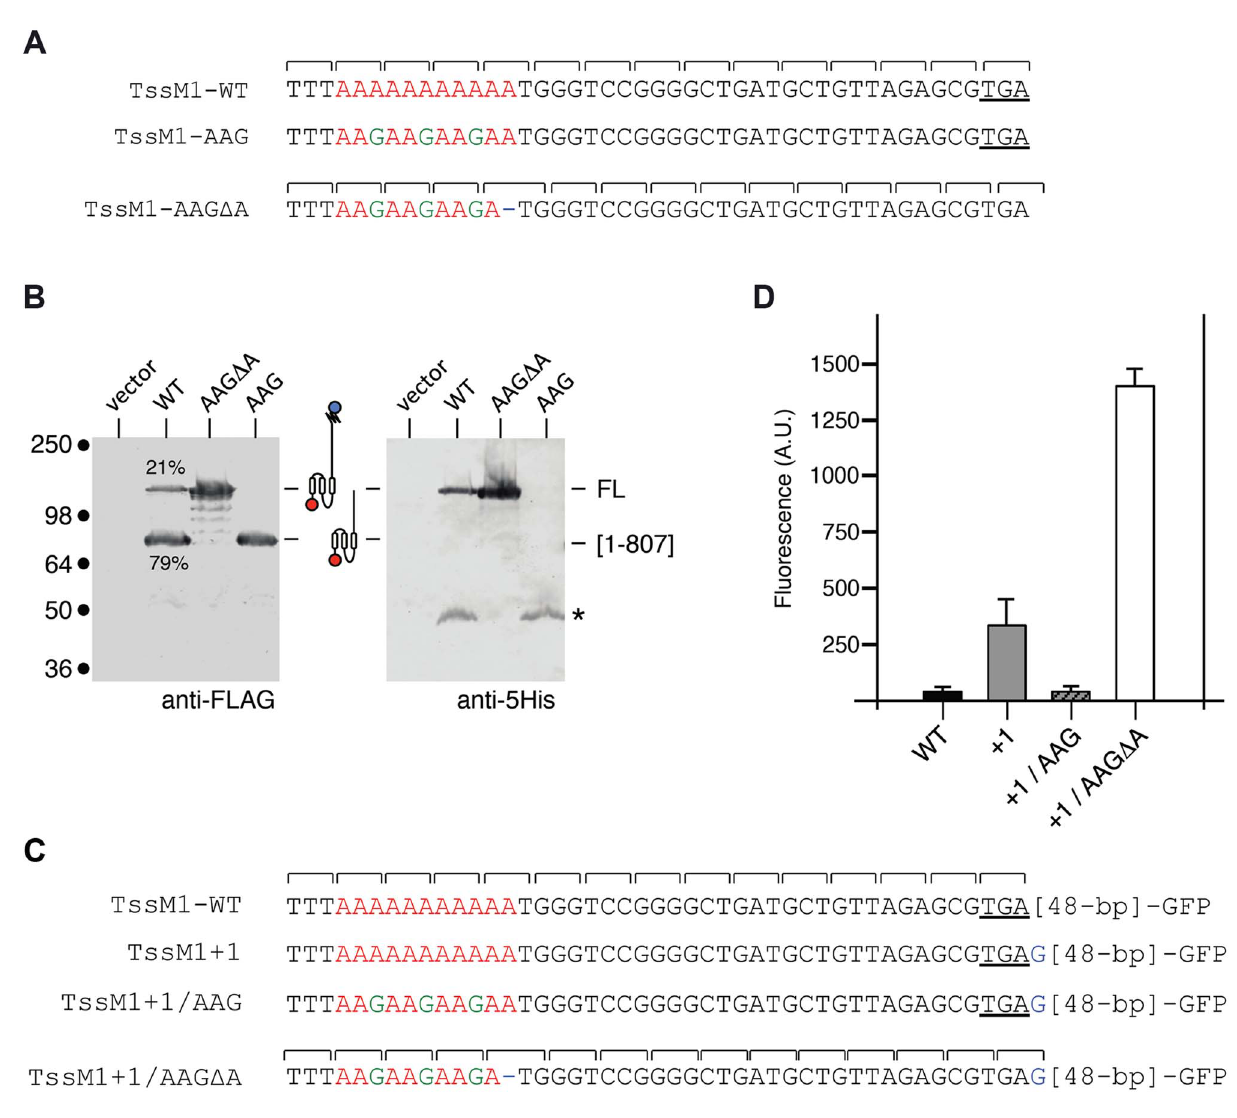
Figure 2. The TssM1 full-length variant is produced through slippage on a poly-A tract. (A) Representation of the nucleotide sequence of C. rodentium tssM1 and of the mutagenized variants used in panel (B). The poly-A tract is shown in red, the mutagenized nucleotides are shown in green. (B) Western-blot analyses of C. rodentium cells producing the indicated TssM1 protein variant bearing a FLAG-epitope tag at the N-terminus and a 6 6 His tag upstream the stop codon resulting from + 1 frameshifting. Crude extracts from 10 9 cells were subjected to 10%-acrylamide SDS-PAGE and immunodetection using the anti-FLAG and anti-5His monoclonal antibodies. The positions of the TssM1-FL and -[1–807] variants are indicated on the right, with the schematic representation in the middle. The relative intensities of these two TssM1 variants are indicated (as %). Molecular weight markers (in kDa) are indicated on the left. (C) Representation of the nucleotide sequence of C. rodentium tssM1 constructs used for fluorescence studies shown in panel (D). The poly-A tract is shown in red, the mutagenized nucleotides are shown in green and additional nucleotides are shown in blue. (D) Fluorescence levels (in arbitrary units, A.U.) of cells producing the different TssM1 variants shown in panel (C). tssM1 frameshifting involves ribosome or RNA polymerase slippage, the molecular masses of tssM1 mRNA products were measured by electrospray ionization mass spectrometry (ESI/MS) as previously reported [37]. Total RNAs were collected from WT C. rodentium cells upon activation of the CTS1 T6SS gene cluster using the recombinant strain carrying inducible promoters [30] and tssM1 cDNA were synthesized and used as template for a